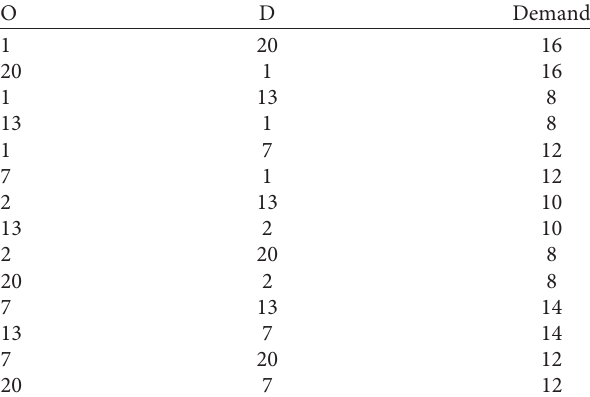
Table 2: Network O-D demand